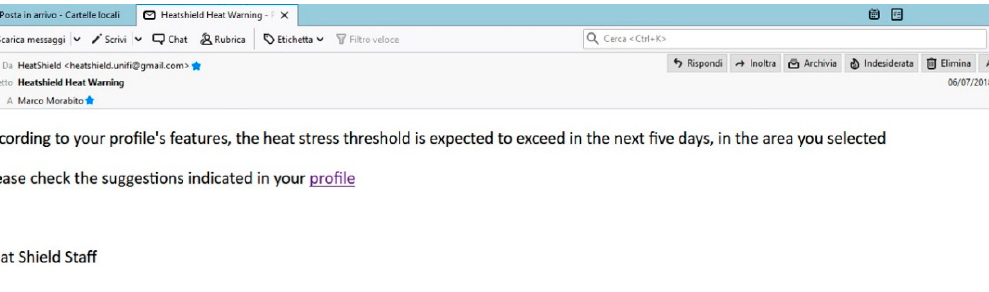
Figure 6. The HEAT-SHIELD warning sent to the user’s e-mail when at least one day with a moderate (or high) heat stress risk level is expected in the short term (the first 5-day forecasts of the HEAT- SHIELD platform).